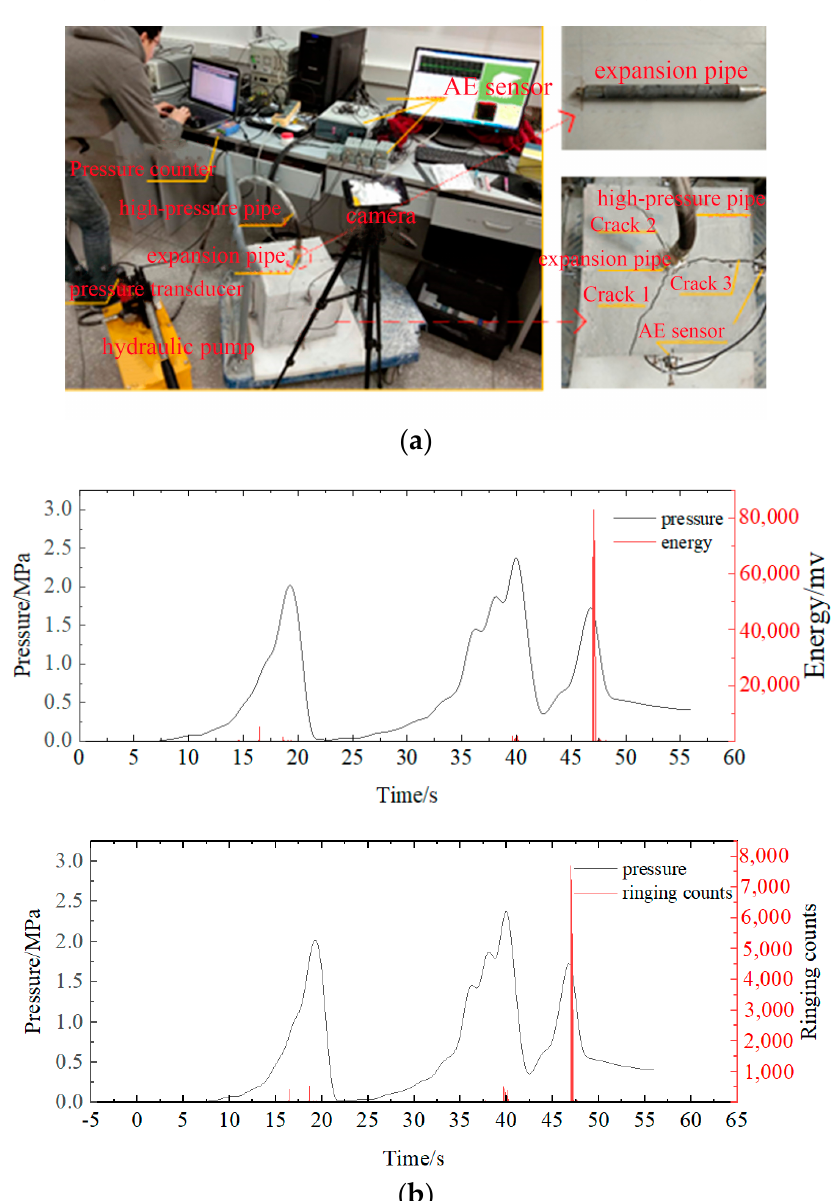
Figure 12. Fracture of rocks under unconstrained cyclic loading. ( a ) Expansive fracturing experi- mental diagram; ( b ) Cracking AE signal.